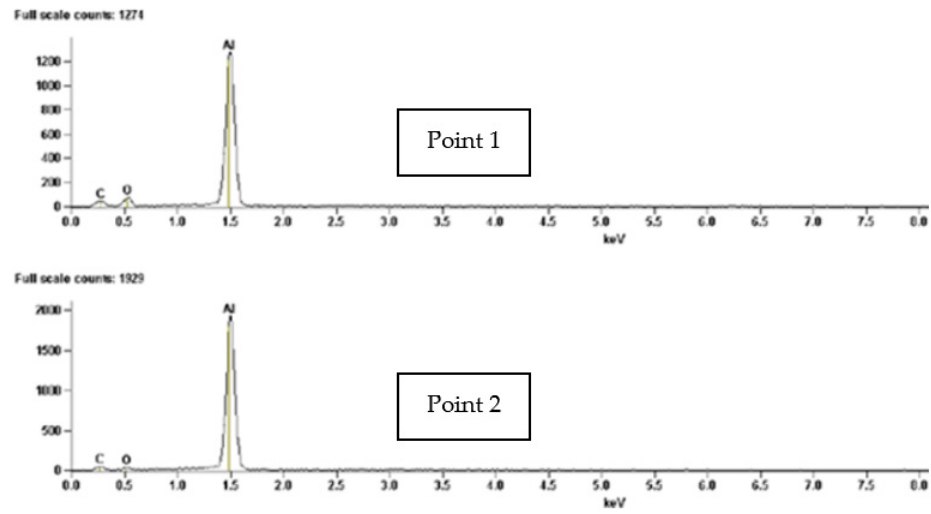
Figure 30. EDS image of right image from Figure 29, showing residual from heated aluminum particles.